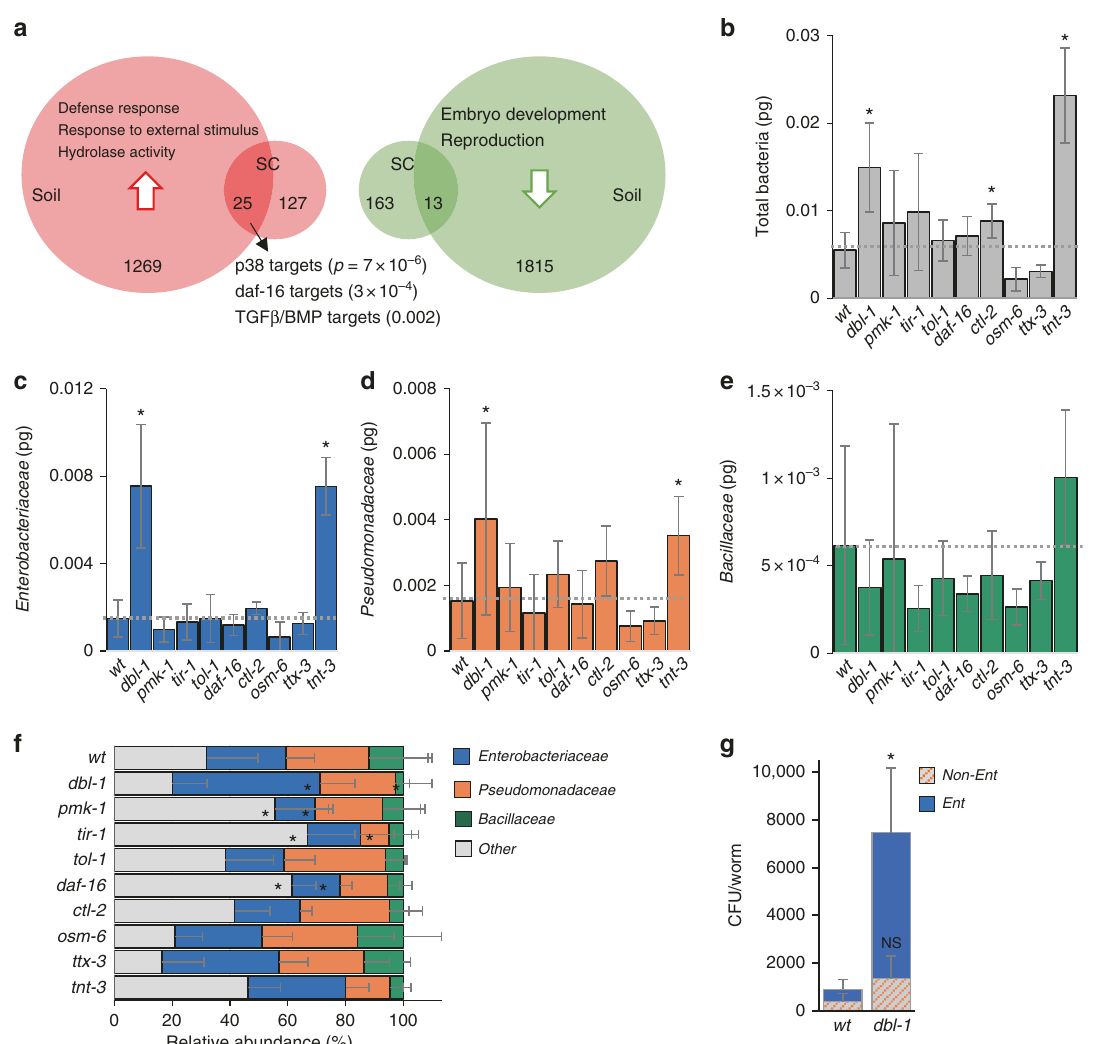
Fig. 1 Genes affected by host – microbiota interactions and involved in shaping the gut microbiota. a Numbers of, and annotations enriched among, genes differentially expressed in worms raised on complex environmental microbiotas compared with those raised on E. coli (detailed in Supplementary Data fi les 1 and 2 and Supplementary Table 1). b – e Bacterial load in worms of the designated strains raised on the SC1 community (in pg 16S rDNA, see Methods): b All Eubacteria, c Enterobacteriaceae , d Pseudomonadaceae , e Bacillaceae . Shown are averages± SD of 2 – 4 independent experiments. Measurements were performed on a pool of 30 worms per experiment. f Relative abundances of each group were calculated based on the values shown in a – d ; light gray bars represent relative abundance of all ‘ other ’ bacterial groups not directly measured. * p < 0.05 (analysis of variance (ANOVA)) compared with N2. g Colony- forming units (CFUs) representing live bacteria extracted from worm guts, cultured and counted on Enterobacteriaceae -selective media plates (Ent) or on rich media plates (LB), which following subtraction of Ent stands for non- Enterobacteriaceae bacteria. Shown are averages± SD of counts from four plates ( n = 10 worms) per group from a representative experiment of four showing similar results. * p = 0.006, t